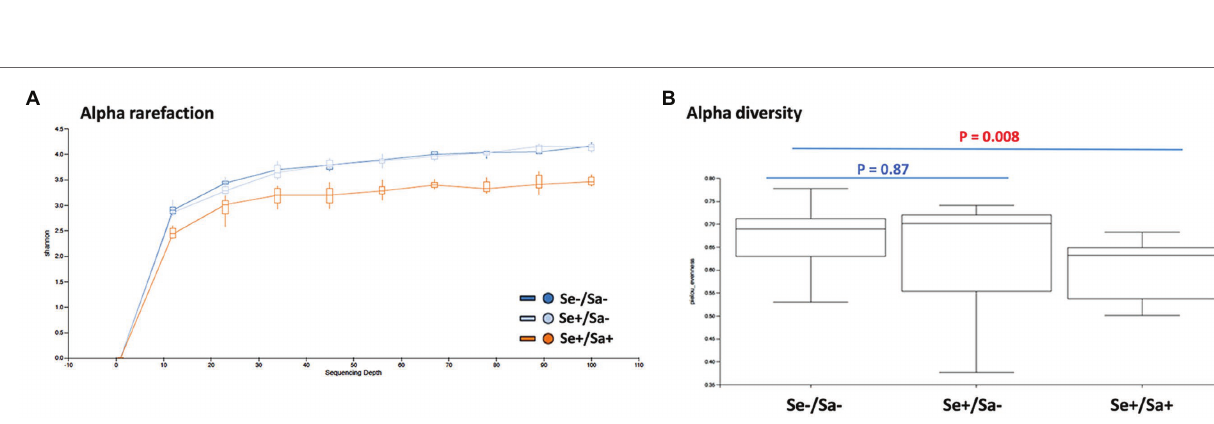
FIGURE 2 | Diversity analysis of oral microbiome in HIV patients with or without Kaposi’s sarcoma-associated herpesvirus (KSHV) coinfection. (A,B) The Alpha rarefaction (Shannon index) and Alpha diversity (Pielou’s evenness) analysis of three groups of HIV patients with or without KSHV